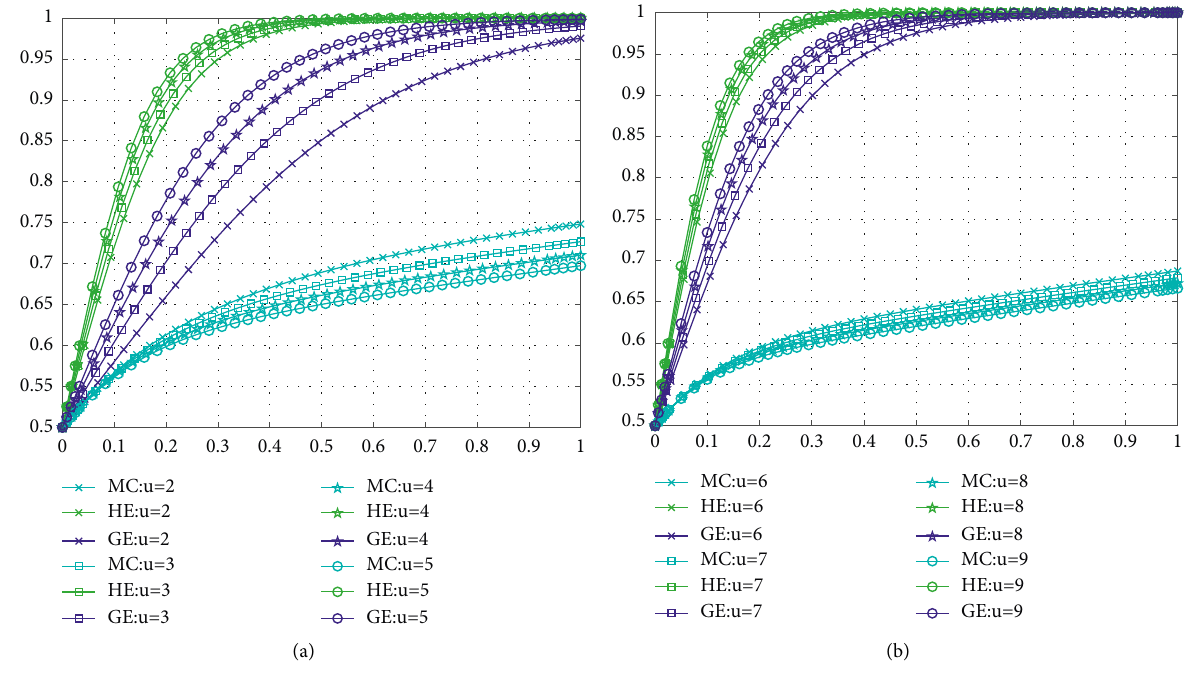
Figure 7: Evolutionary results of changes in patent royalty.